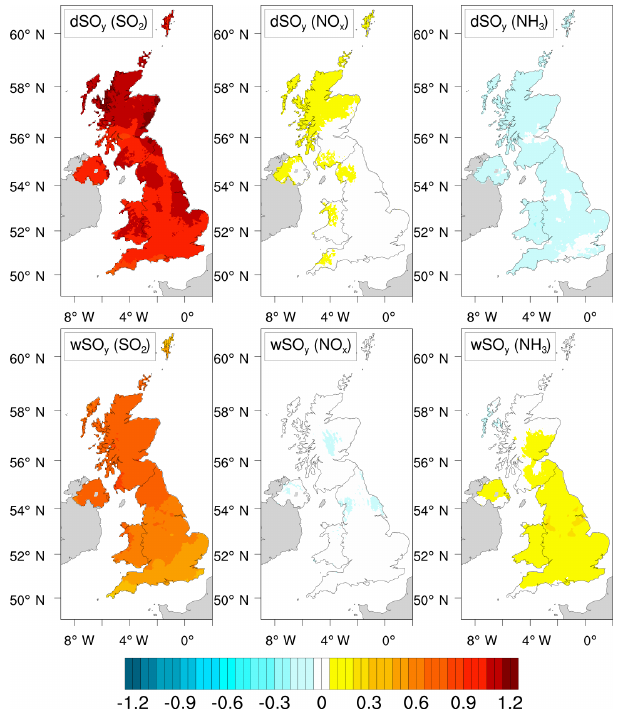
Figure 3. Spatial distributions (at the 5km × 5km model grid reso- lution) of RCs of dry (d) and wet (w) deposition of SO y as a func- tion of variation in input emissions of SO 2 , NO x , and NH 3 . The model input emissions for which the RC quantifies the output vari- able sensitivity is given in the brackets in each